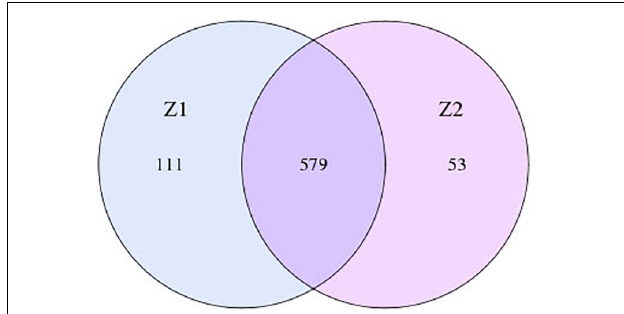
FIGURE 2 | OTU numbers of intestinal flora in the patients in the Control group before and after treatment (Z1, the Electroacupuncture group before treatment; Z2, the Electroacupuncture group after treatment; D1, the Control group before treatment; D2, the Control group after treatment).